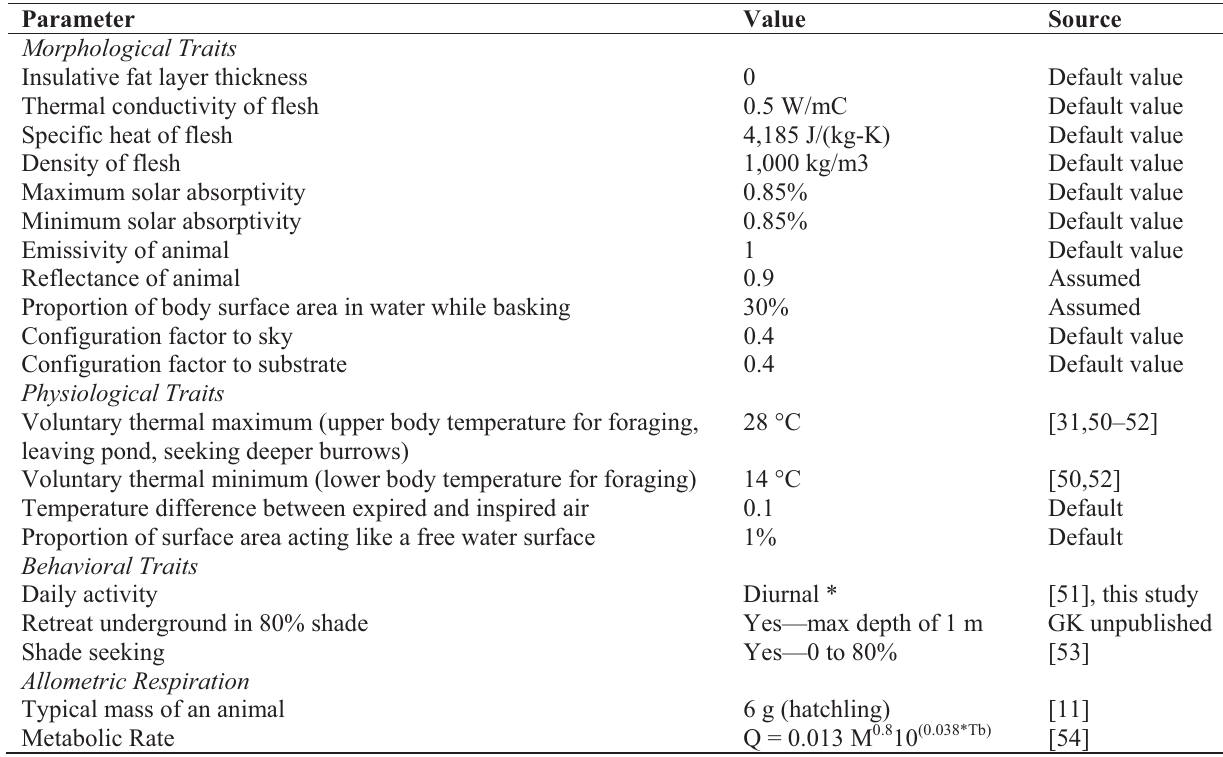
Table 2. Parameters for the biophysical model of P. umbrina that were used to predict the thermodynamic